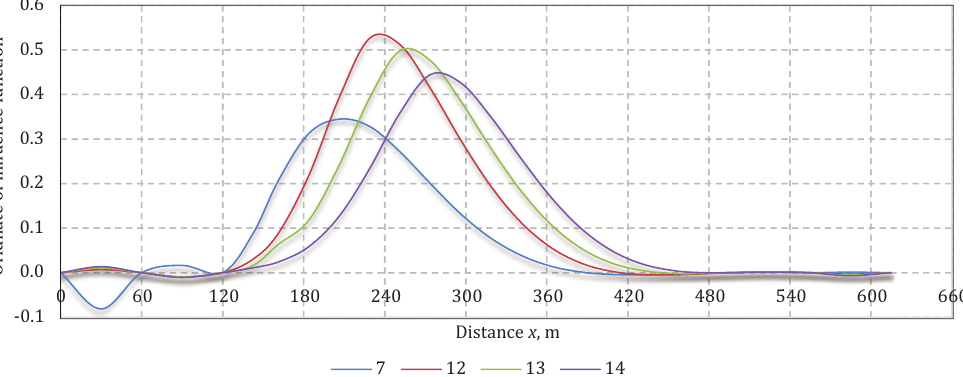
Figure 5. Diagrams of the influence functions of the axial forces in the cables used in analysis, i.e., Nos. 7, 12, 13, 14